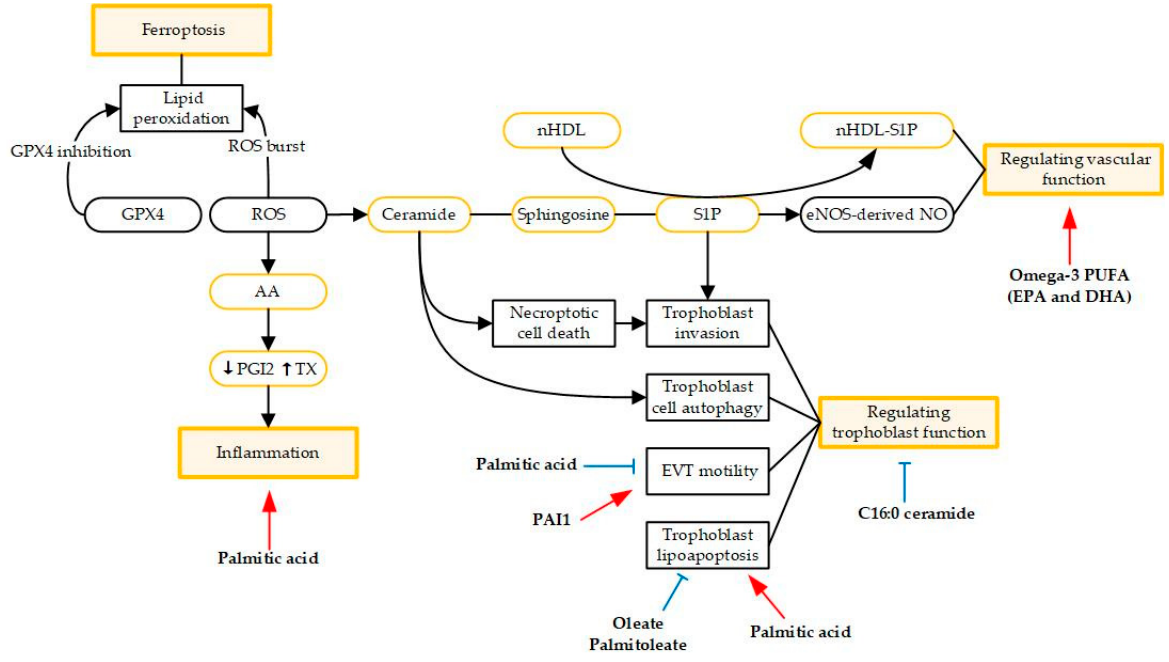
Figure 1. Schematic view of the roles of lipids in preeclampsia pathogenesis. Red arrows indicate stimulatory activity and bule arrows indicate inhibitory activity. Abbreviations: arachidonic acid (AA); extravillous trophoblast (EVT); high-density lipoprotein (HDL); plasminogen activator inhibitor-1 (PAI1); prostacyclin (PGI2); polyunsaturated fatty acids (PUFA); reactive oxygen species (ROS); sphingosine-1-phosphate (S1P); thromboxane (TX).